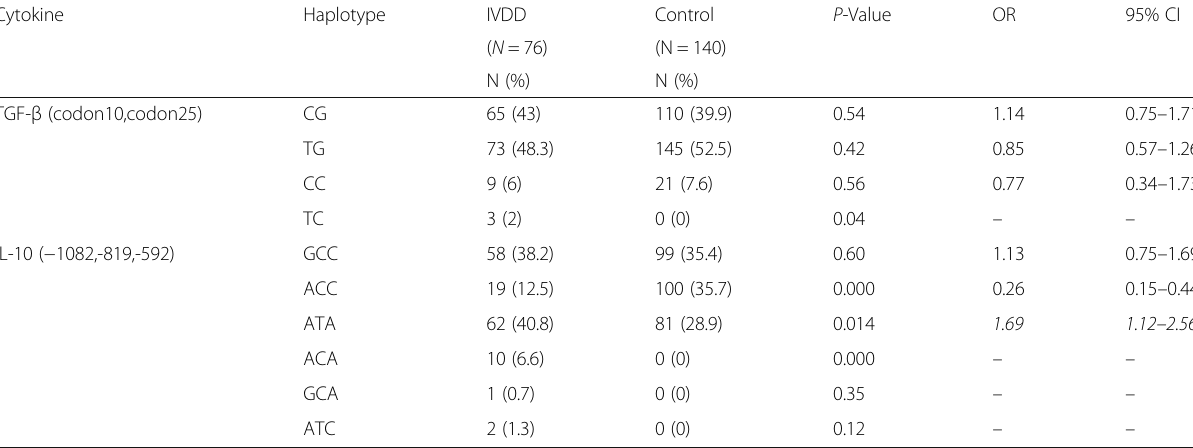
Table 3 IVDD-Control haplotype frequency comparison